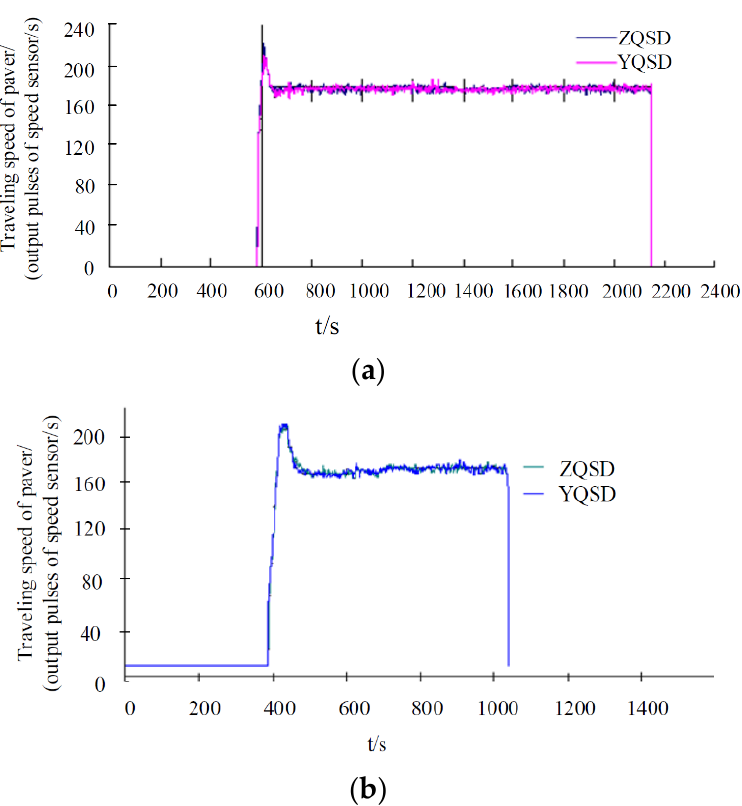
Figure 5. Constant speed test of paver when driving straight. ( a ) Constant speed test of the paver with the new control scheme when driving straight. ( b ) Constant speed test of the paver with the old control scheme when driving straight. ZQSD—Speed of the left wheel, and YQSD—speed of the right wheel.